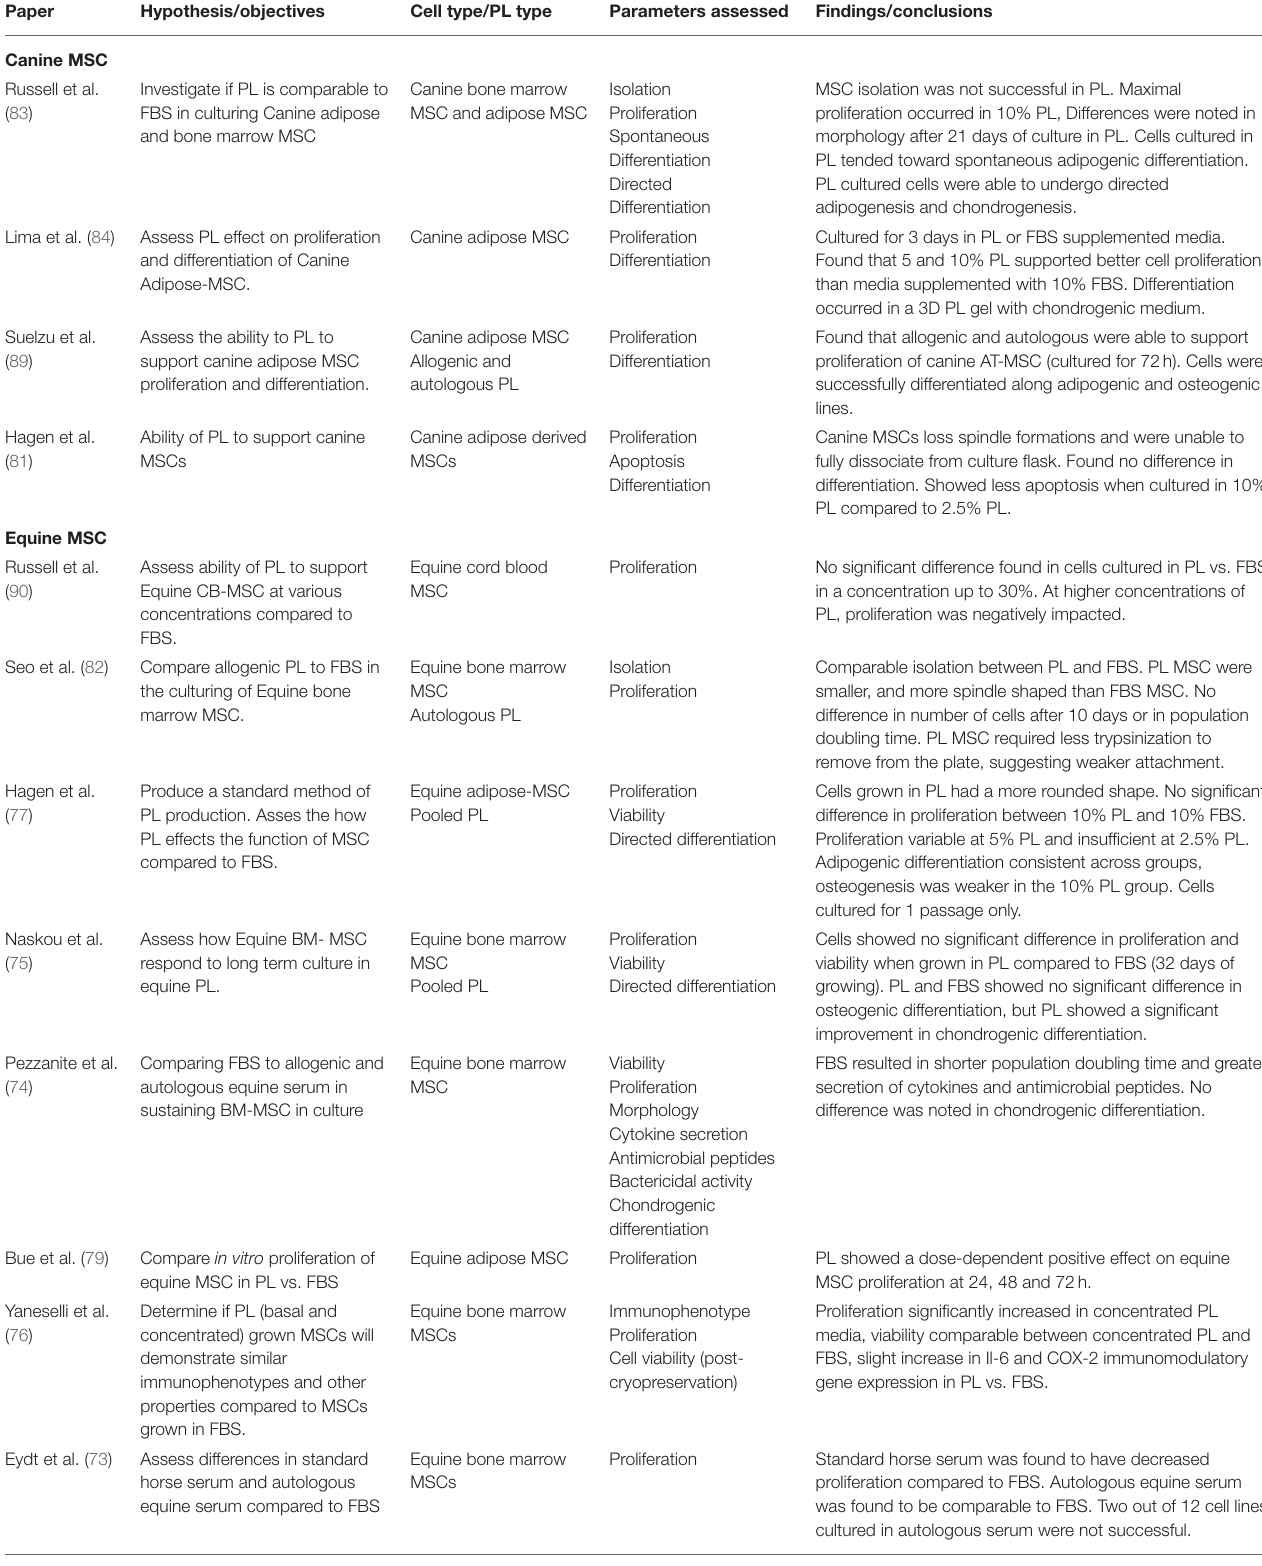
TABLE 2 | Autologous blood products evidence